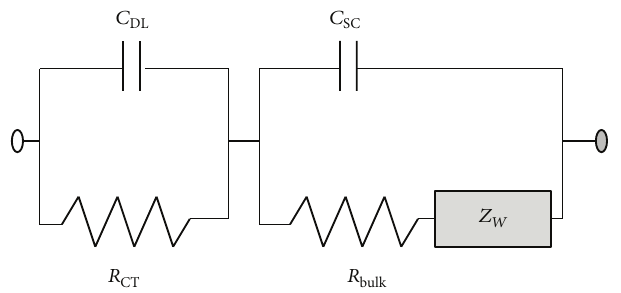
Figure 13: Proposed scheme of equivalent circuit for CS NiO 𝑥 polarized at 2.8 V versus Li +